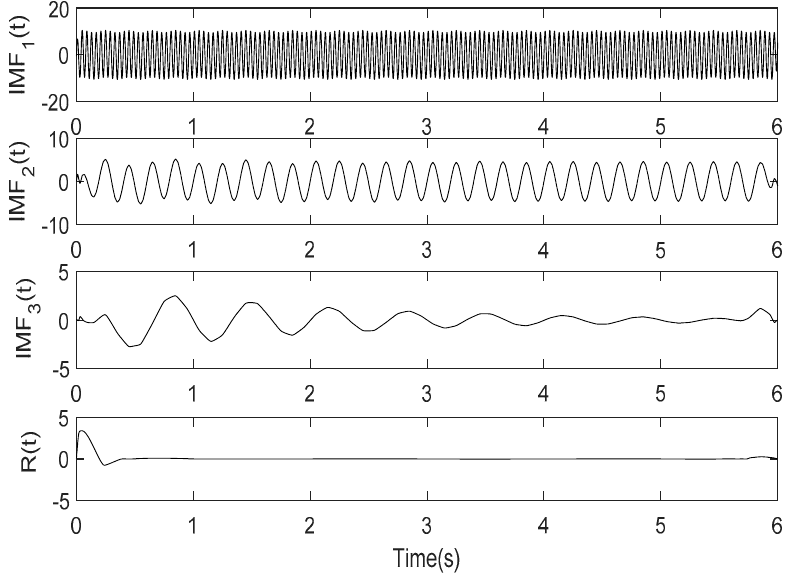
Figure 8. Empirical mode decomposition (EMD) results of the simulation signal x ( t ).